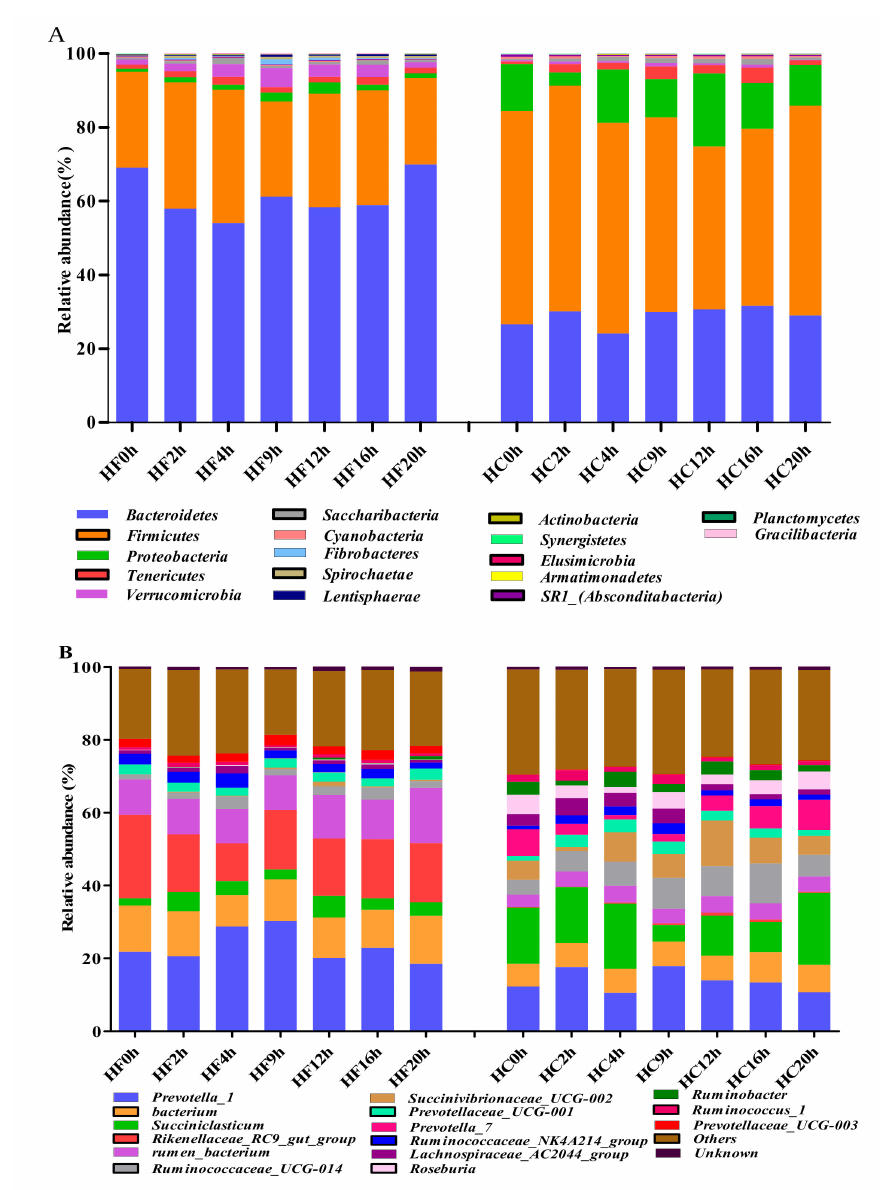
Figure 4. Histogram of relative abundance. The x -axis represents the groups, and the y -axis represents the relative abundance presented as percentage. ( A ) Relative abundance of the top 15 phyla. ( B ) Relative abundance of the top 15 genera. Only the top 15 species in abundance are shown in the figure; other species were combined as